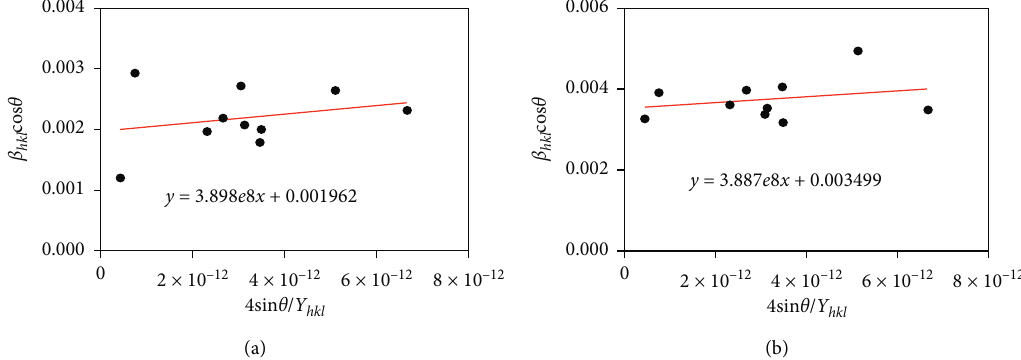
Figure 3: USDM plot for Al 2 O 3 /10wt. % SiC: (a) electrical resistance heating sintering; (b) microwave sintering.